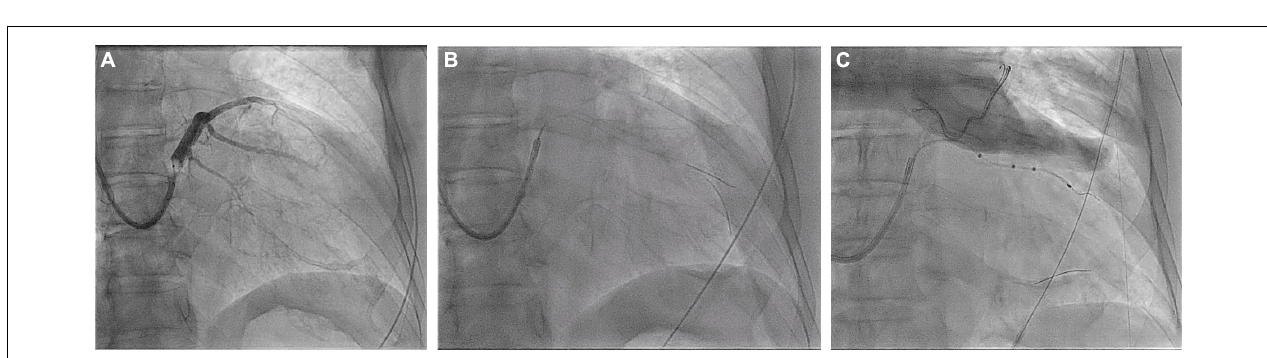
FIGURE 3 | Coronary sinus venogram (A) and fluoroscopic images identifying the sharply angulated posterolateral branch of the coronary sinus (B) and the placement of the LV pacing lead using the double wire technique (C) (see text for details).